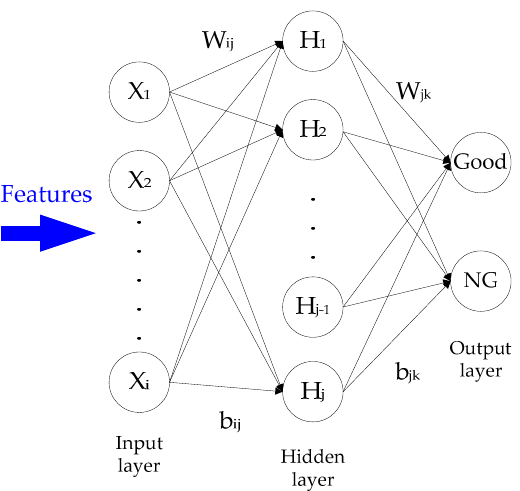
Figure 9. Structure of back-propagation neural network (BPNN) classifier.